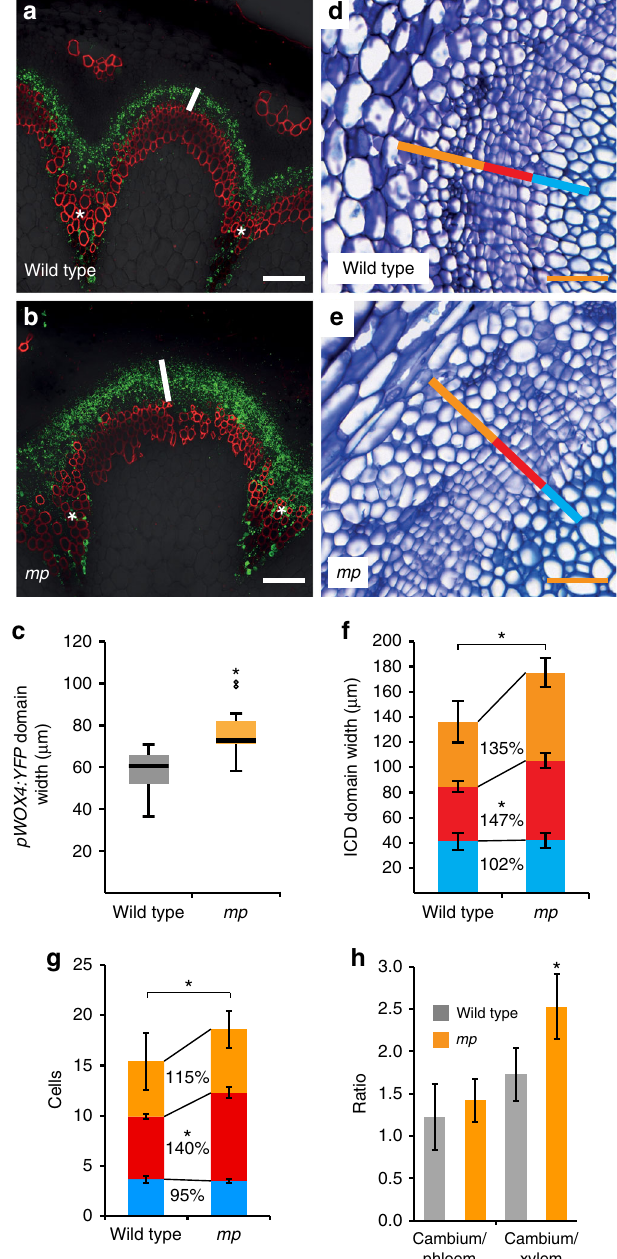
Fig. 6 ARF5 activity reduces the number of cambium stem cells. a , b Confocal analyses of cross-sections at the stem base of wild-type and mp- S319 mutant plants containing pWOX4:YFP . White bars mark the pWOX4: YFP domain. Asterisks mark vascular bundles. Size bars represent 100 µ m. c Quanti fi cation of pWOX4:YFP domain width at the stem base of wild-type and mp-S319 plants. Student ’ s T -test was performed comparing wild-type and mp-S319 mutants ( p = 2.65E-03, sample size n = 8 – 11). The T-bars that extend from the boxes (whiskers) are expected to include 95% of the data. Signi fi cance is indicated by the asterisk. d , e Toluidine blue-stained cross- sections at the stem base of wild-type and mp-S319 plants. Interfascicular regions are shown and the width of the vascular tissues phloem (orange bar), cambium (red bar) and xylem (blue bar) are marked. Size bars represent 50 µ m. f Quanti fi cation of the width of the vascular tissues phloem (orange), cambium (red) and xylem (blue) and the ICD at the stem base of wild-type and mp-S319 plants. Student ’ s T -test was performed comparing wild-type and mp-S319 mutants (phloem p = 8.52E-02, cambium p = 2.67E-04, xylem p = 0.87 and ICD p = 3.06E-02, sample size n = 5 – 8). Error bars represent ±standard deviation. Signi fi cance is indicated by asterisks. g Quanti fi cation of phloem (orange), cambium (red) and xylem (blue) cell numbers in interfascicular regions. Student ’ s T -test was performed comparing wild-type and mp-S319 mutants (phloem p = 0.34, cambium p = 3.67E-05, xylem p = 0.57 and all cells p = 0.02, sample size n = 5 – 8). Error bars represent ±standard deviation. Signi fi cance is indicated by asterisks. h Ratio of the radial extensions of cambium vs. phloem and cambium vs. xylem in wild-type and mp-S319 mutants. Student ’ s T -test (cambium/xylem p = 1.09E-02) or Welch ’ s T -test (cambium/phloem p = 1.0) were performed comparing wild-type and mp-S319 mutants (sample size n = 5 – 8). Error bars represent ±standard deviation. Signi fi cance is indicated by the